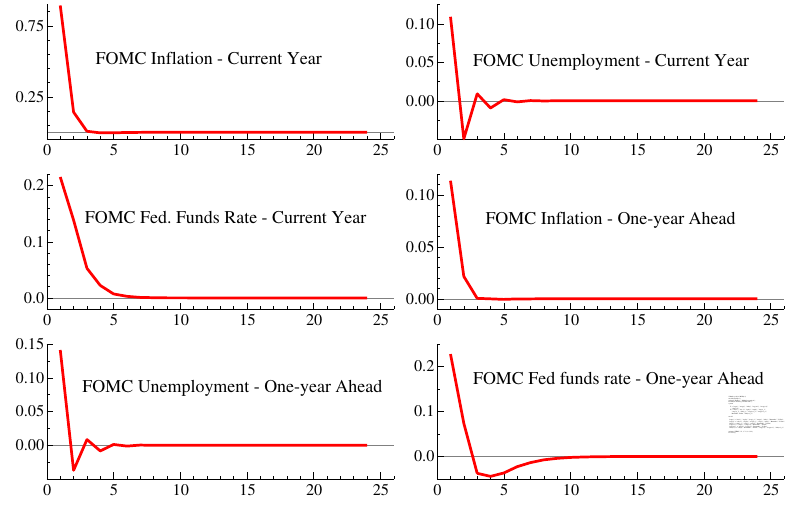
Figure 13. Impulse Responses to a one-percent inflation revision